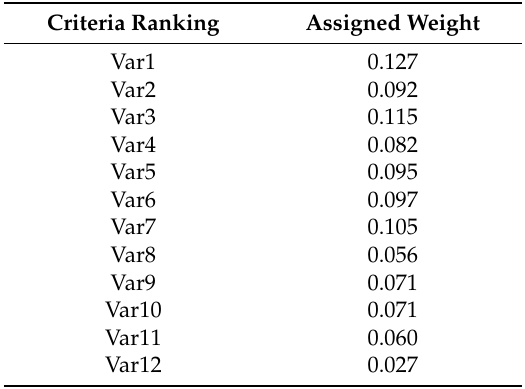
Table 7. Variable weights assigned according to the